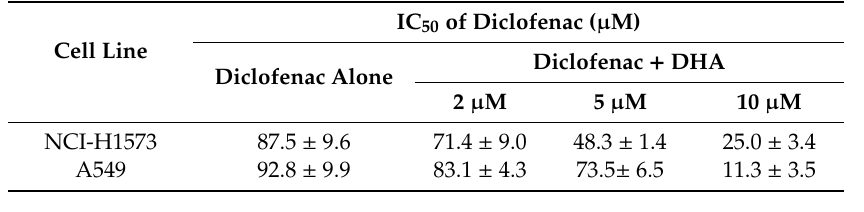
Figure 1. Suppression of cell viability by co-treatment of DHA and diclofenac in NCI-H1573 and A549 human lung cancer cells. Cultured cells were seeded in 96-well plates seeded at a density of 1 × 10 4 were exposed to diclofenac (0–500 μ M) alone or with DHA ( ● 0 μ M, ○ 2 μ M, ■ 5 μ M or □ 10 μ M) for 48 h. Cell viabilities were determined after the final treatment by fluorescence using the resazurin reduction assay. Each point represents the mean ± SEM relative to the control untreated cells.